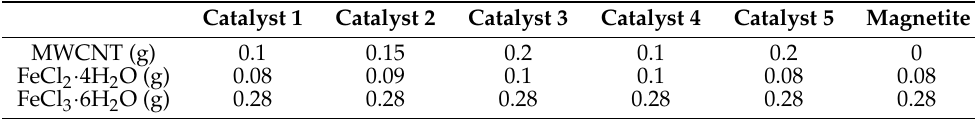
Table 5. Composition of the prepared Fe 3 O 4 /MWCNTs